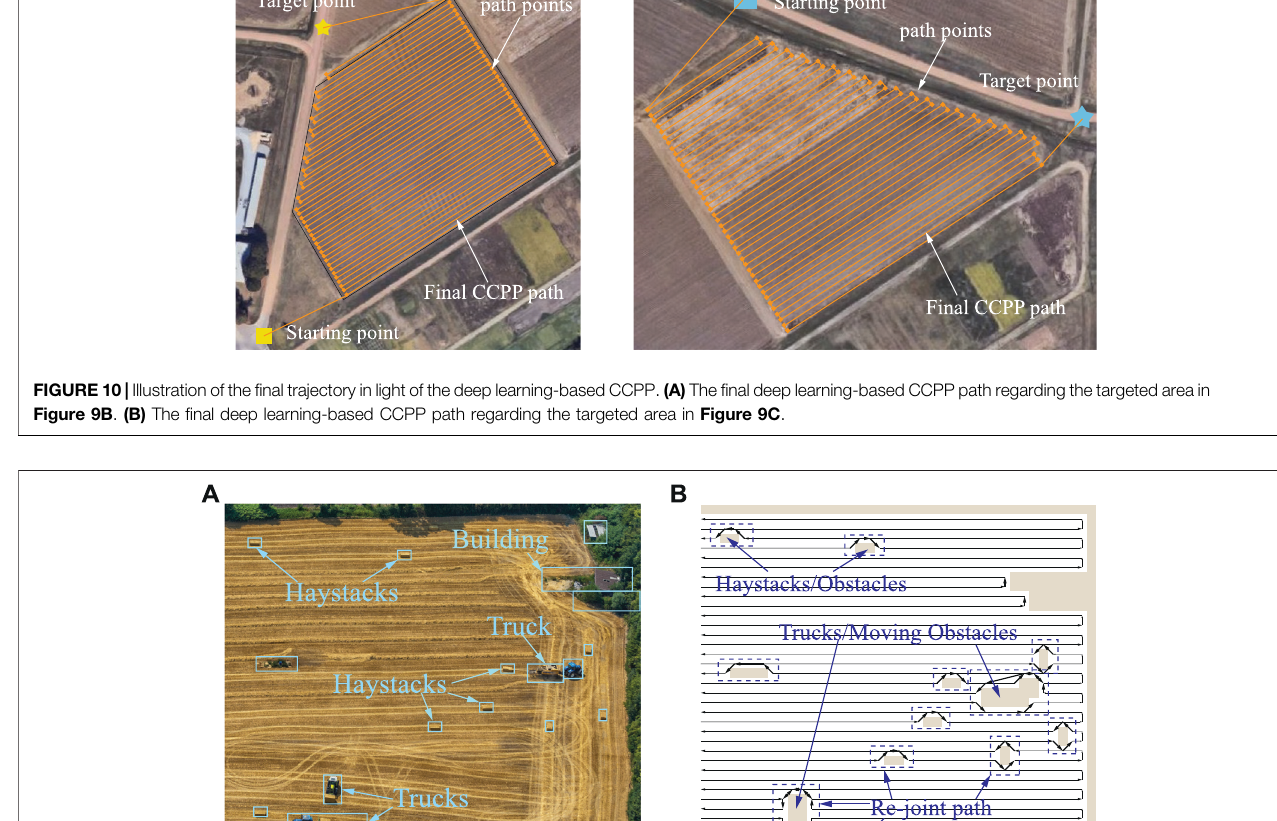
The average precision (AP) metric is utilized to evaluate the training results. A total of 3000 synthetic images with a resolution of 800 × 800 are utilized for training and h = 8.